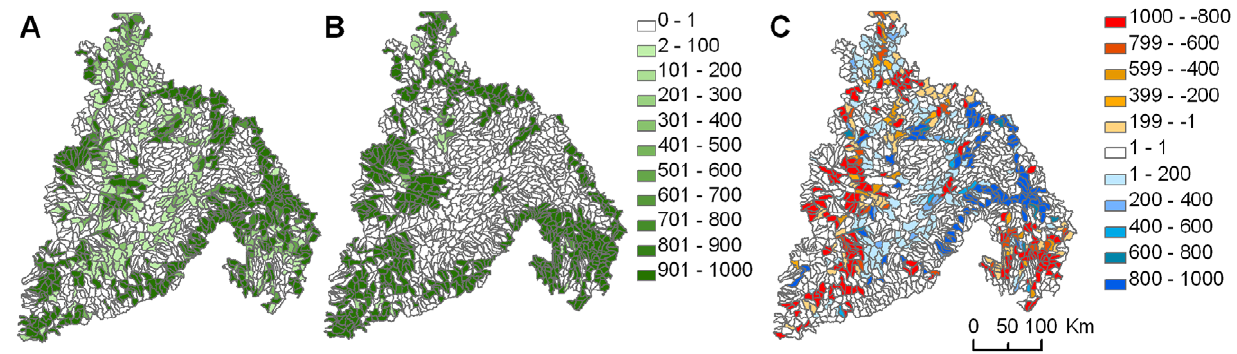
Figure 7. Comparison of irreplaceability of planning units in the restore vs. protect scenarios. Irreplaceability is measured as the number of times a planning unit was selected across 1000 potential networks. Irreplaceablilty values are mapped for networks prioritized to represent abiotic elements restricted to $ 60% naturalness (i.e., grid cells with $ 60% natural land types) (A) and $ 80% naturalness (B). The differences in irreplaceability values between the two networks (A and B) are mapped (C). Blue areas indicate additional conservation opportunities in the network when restoration is an option for the region.